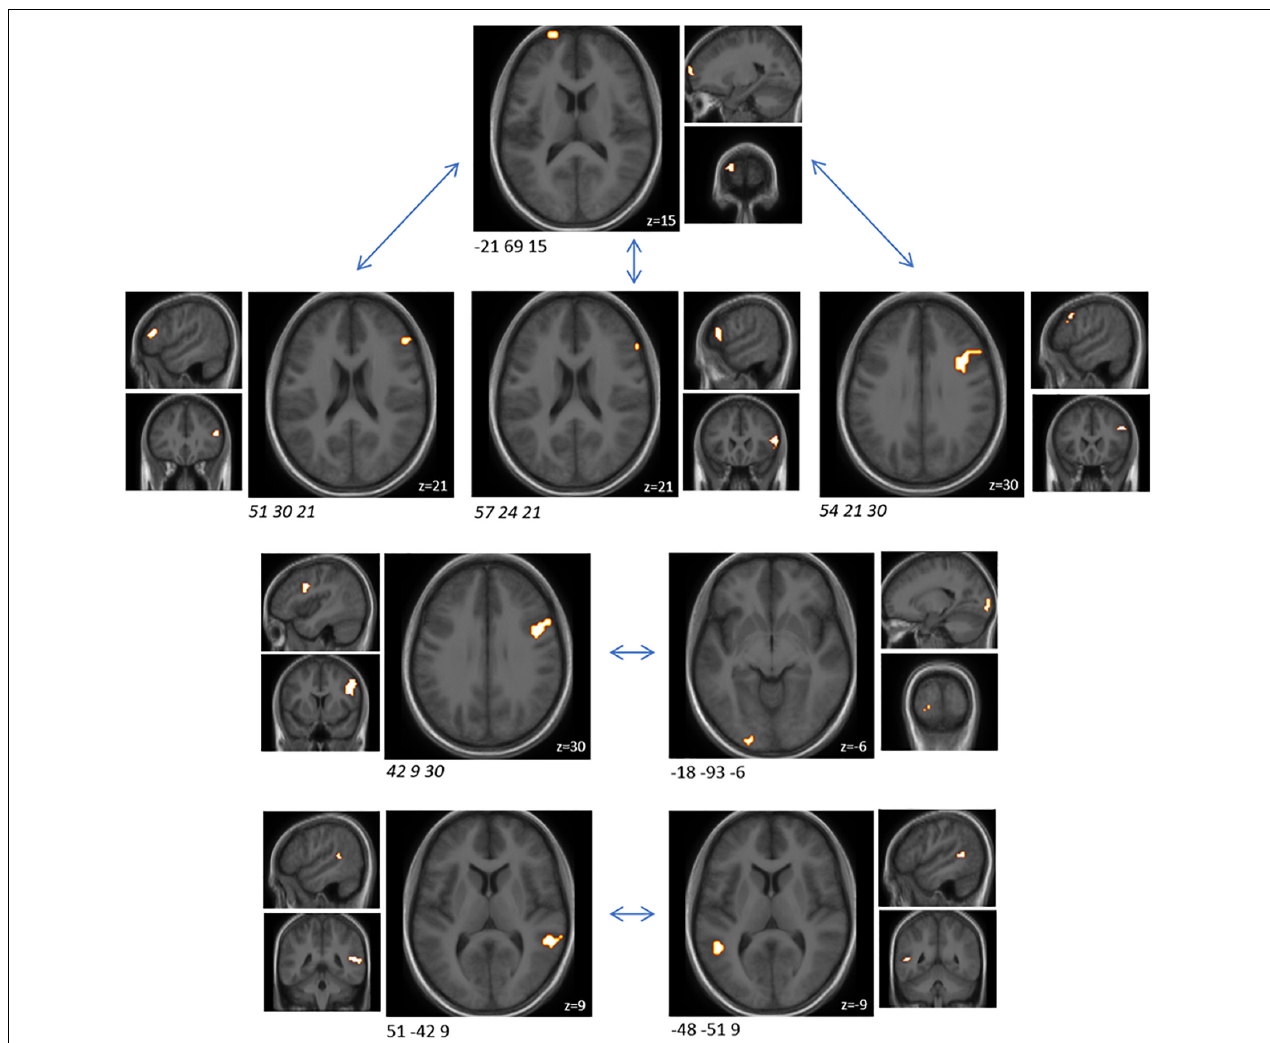
FIGURE 3 | Cluster pairs that were found to be associated with significant (FDR-corrected p < 0.05) connectivity changes between both interventions (probiotic < placebo), during the EAT paradigm. None of these sub-clusters was among the predefined ROIs. Four of those sub-cluster belonged to the same larger cluster spanning over several BNA regions (italic). Clusters are superimposed on average anatomical scans. Clusters can be identified by the coordinates of their peak (x y z). BNA, Brainnetome atlas; EAT, emotional attention task; FDR, false discovery rate; ROI, region of